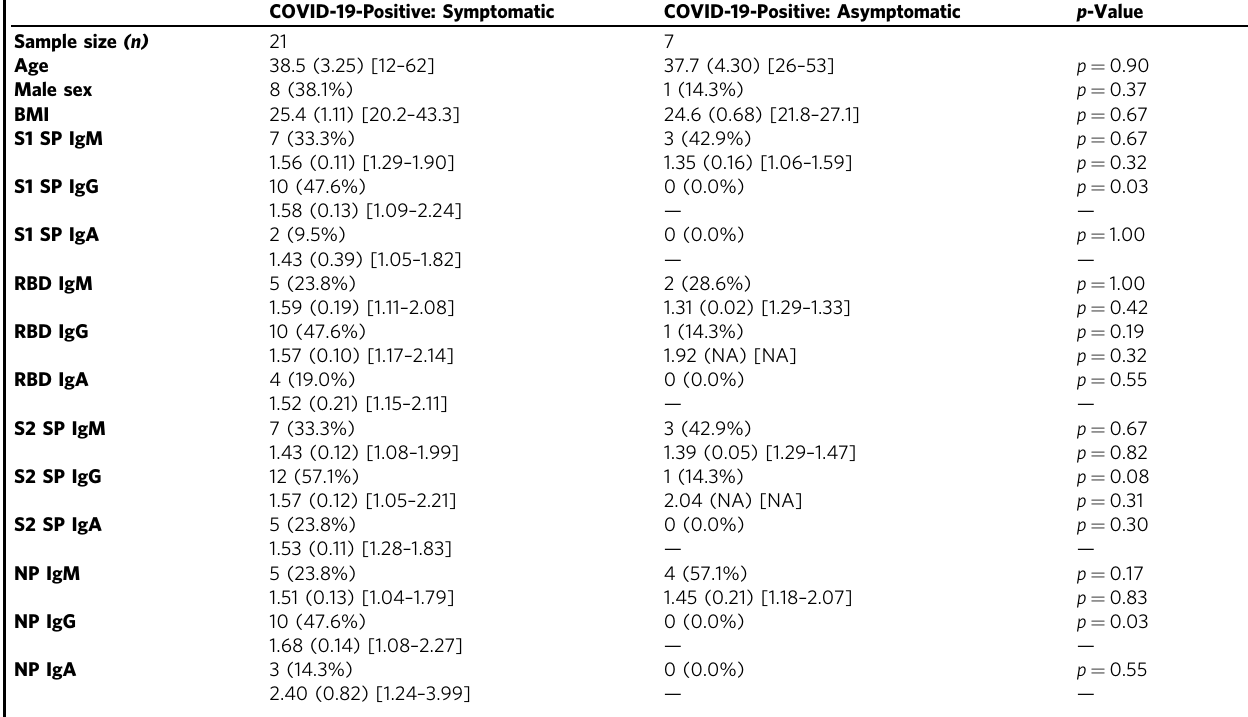
Age, sex, and BMI are also shown for comparison in symptomatic ( n = 21) and asymptomatic ( n = 7) COVID-19-positive participants. For each antibody/antigen combination, the number of positive participants(%)is indicated.Titer valuesare giveninAU/mL andresults arepresented asmean (SE)[range]. p -valuesweredeterminedvia two-tailedIndependentSamples t-Testsfor continuousdata, Chi-Squared Tests for categorical data with >5 cases per cell, and Fisher ’ s Exact Tests for categorical data with <5 cases per